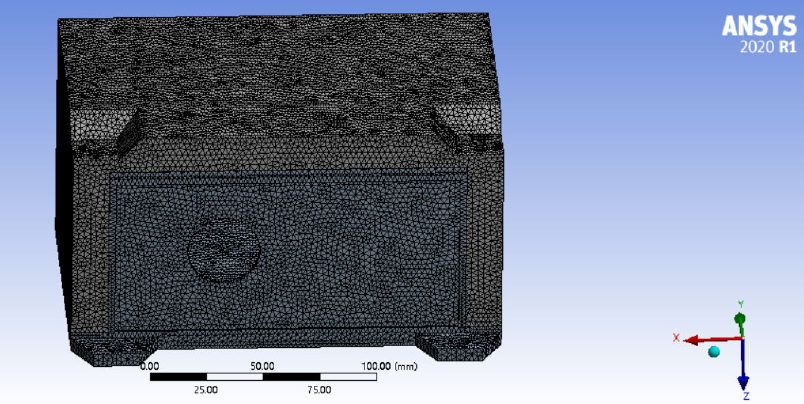
Figure 5. Electric control box finite element model.